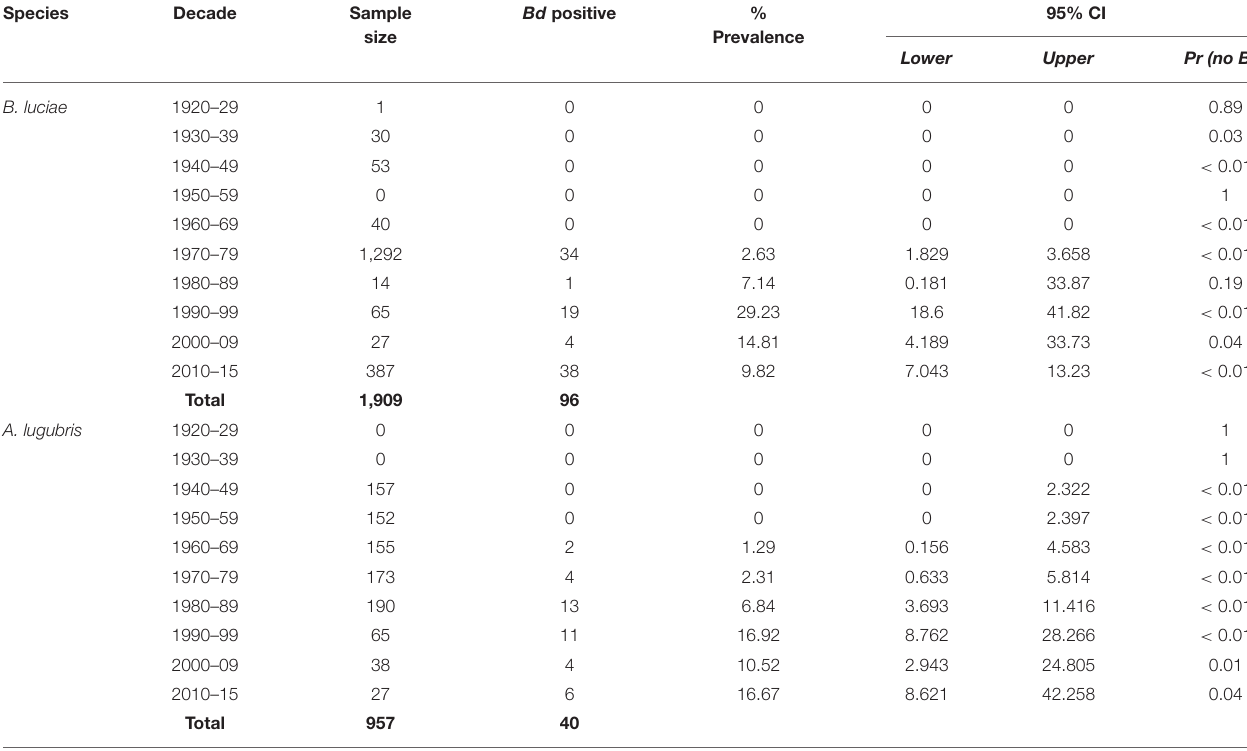
TABLE 1 | Batrachochytrium dendrobatidis ( Bd ) prevalence in the Santa Lucia Mountains slender salamander ( Batrachoseps luciae ) and the arboreal salamander ( Aneides lugubris ) museum specimens collected in California. Species